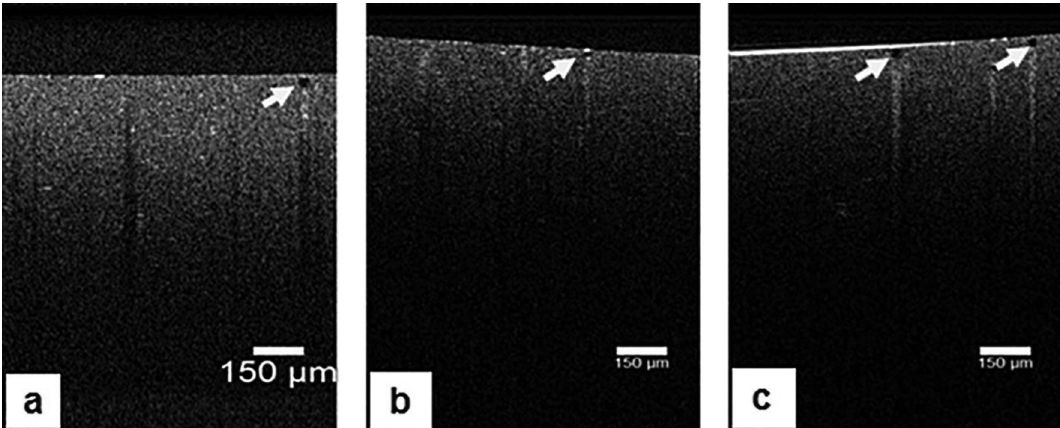
FIGURE 6 - Tomographic images of the emulsified systems (1:100 dispersion in purified water); where (a) ES-1, (b) ES-2 and (c) ES-3. The arrows indicate possible droplets of the emulsion’s inner